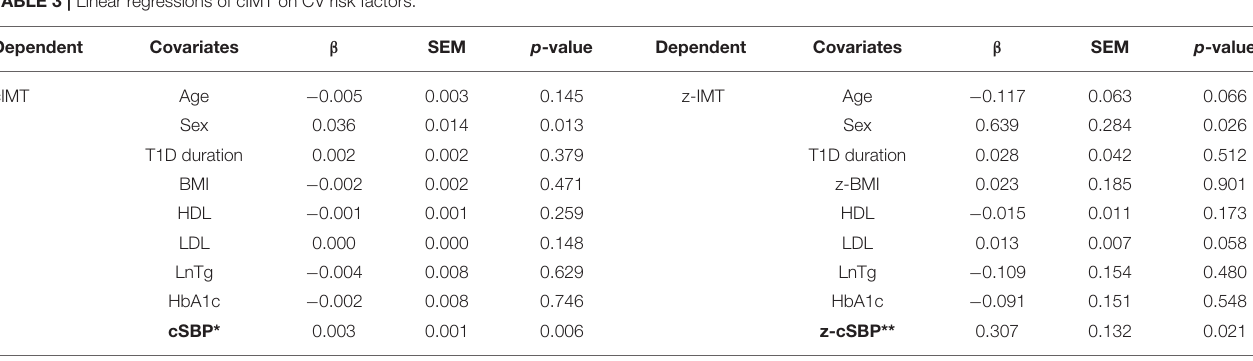
TABLE 3 | Linear regressions of cIMT on CV risk